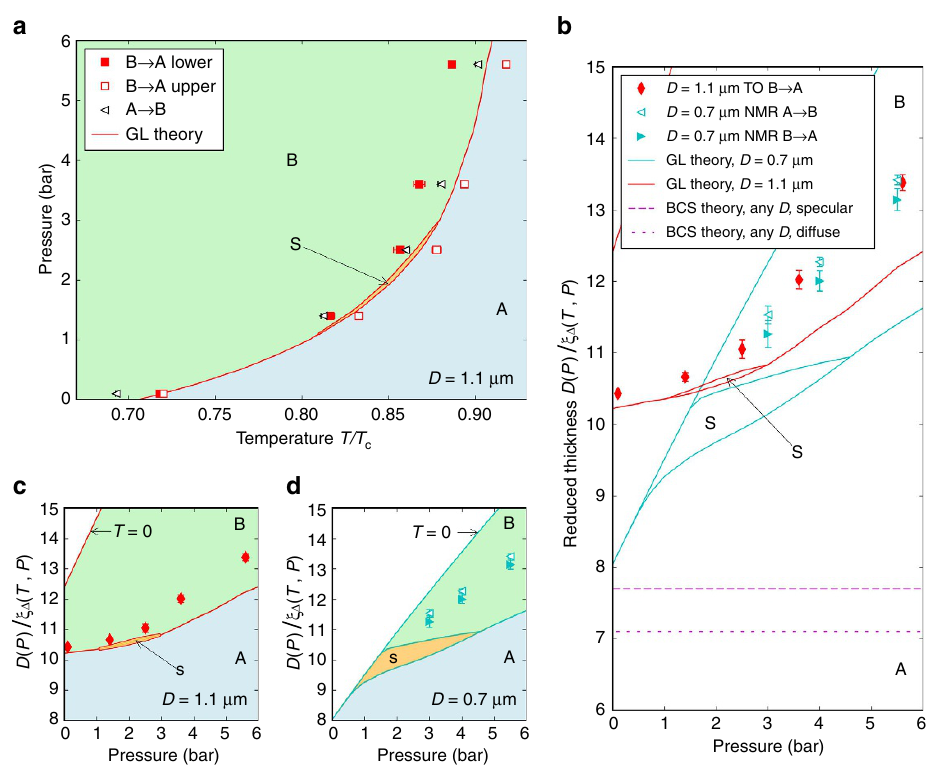
Figure 6 | Phase diagram of superfluid 3 He confined in slab geometry. ( a ) The A–B transition in the D ¼ 1.1 m m slab (this experiment) in the temperature– pressure plane. The start, T lower (filled squares), and completion, T upper (open squares), of the B–A transition on warming correspond to the equilibrium B–A BA BA transition in the thinnest (fixed D ¼ 1.08 m m near the edge) and thickest (pressure-dependent D ) parts of the cavity, respectively. On cooling the A phase supercools down to T AB (black triangles). Solid red lines and blue/orange/green areas show the A/stripe-S/B phase diagram predicted by the GL theory 22 with experimentally determined strong coupling parameters for D ¼ 1.08 m m, therefore directly comparable to T lower . The A phase is observed in the BA predicted region of stability of the stripe phase (orange), demonstrating the inaccuracy of the strong coupling parameters used for the calculation 22 . ( b ) The reduced thickness D / x D representation of the phase diagram allows comparison of this TO experiment (in this representation T lower and T upper BA BA coincide) with the NMR experiment on a D ¼ 0.7 m m slab 36,37 (due to hysteresis the equilibrium transition was not observed, here the data on warming and cooling are shown). The two data sets’ collapse demonstrates the universality of D / x D at the A–B transition. These measurements strongly deviate from the prediction of the weak coupling (BCS) theory, shown here for diffusely and specularly scattering cavity walls 57 . Since the nature of boundary scattering only weakly affects coordinates of the BCS A–B interface, we compare the experiments with diffuse walls to the predictions of the GL theory only available for specular walls 21,22 (same in a ). The phase boundaries derived within the GL theory for D ¼ 1.08 m m and 0.7 m m (red and cyan lines in b ), also shown separately in ( c ) D ¼ 1.08 m m and, ( d ) D ¼ 0.7 m m depart from the D / x D collapse due to the temperature dependence of the strong coupling included in the theory 21,22 . The disagreement between the experiments and GL theory emphasizes the current limited understanding of the strong coupling parameters at low pressure that leaves the stability of the stripe phase uncertain. Error bars represent pressure. The theoretical lines for D ¼ 0.7 m m and 1.1 m m are